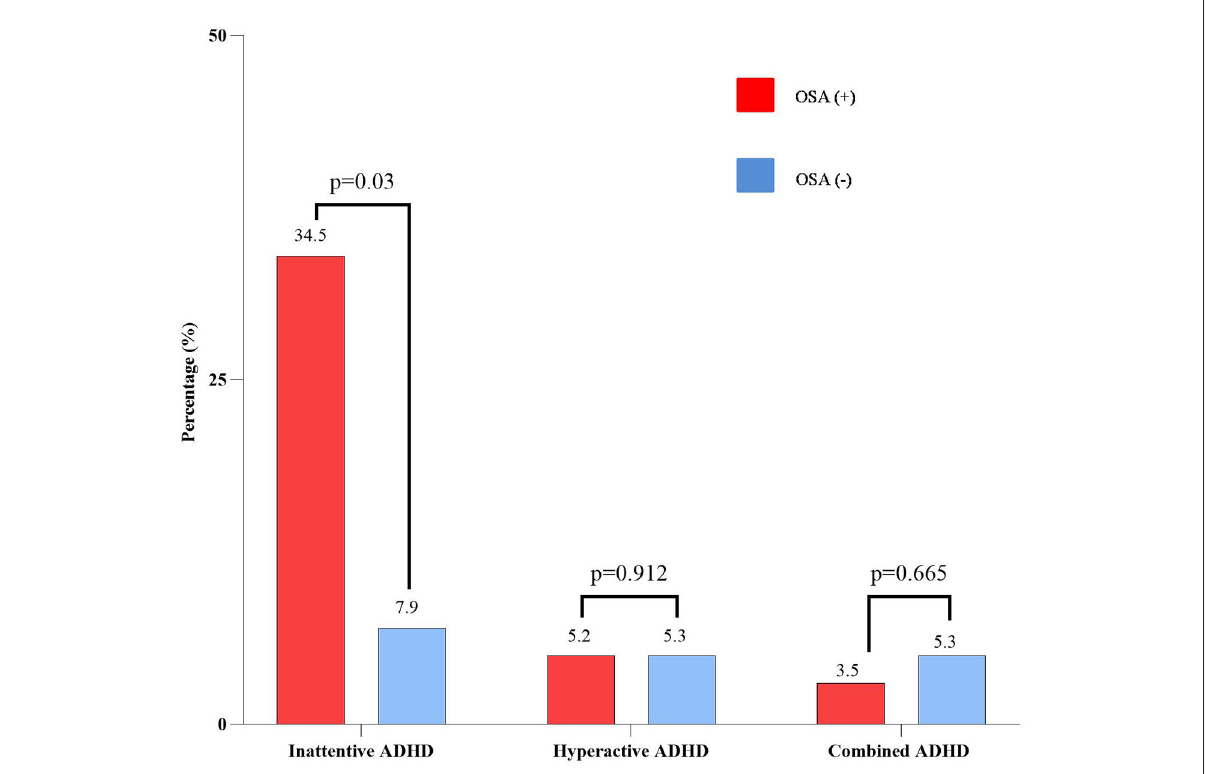
FIGURE3 Parent-reported ADHD symptoms of the study subjects classified by OSA. ADHD, attention deficit and hyperactivity disorder; OSA, obstructive sleep apnea.